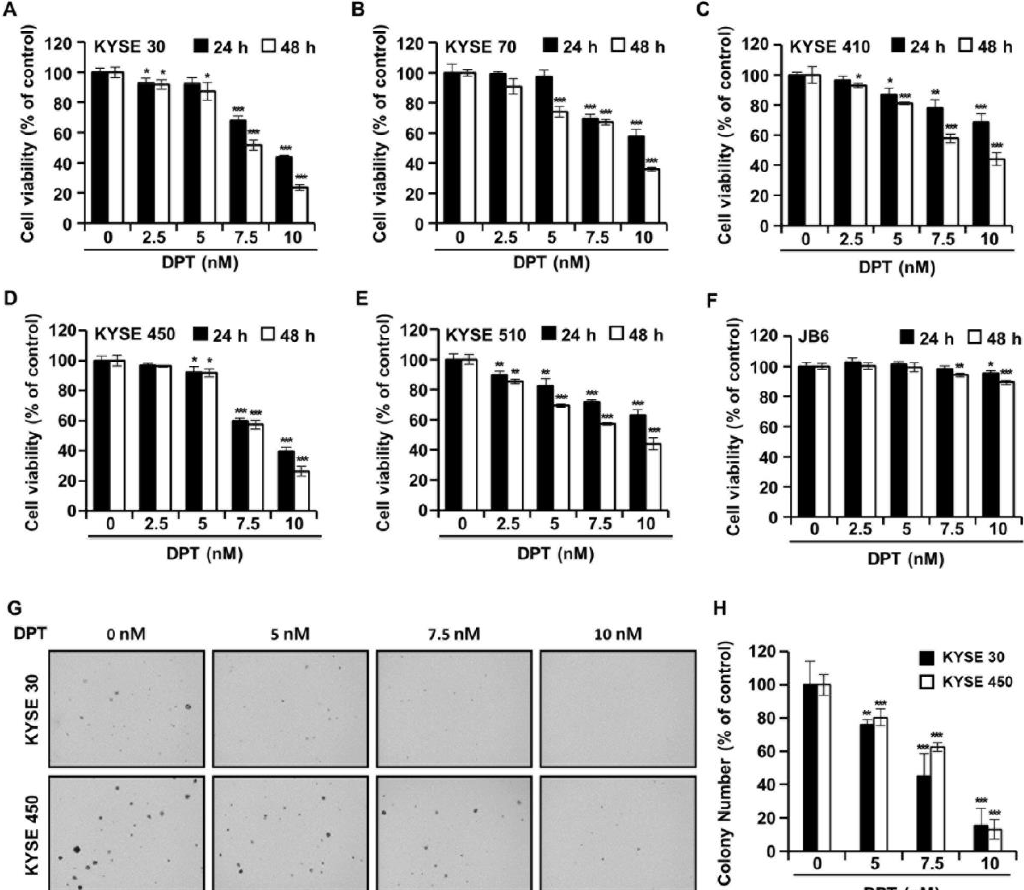
Figure 2. The effects of DPT on cell viability and anchorage-independent growth capability in ESCC cells. ( A – F ) Cell viability was determined after treatment with 0, 5, 7.5, and 10 nM of DPT for 24 and 48 h in JB6 cells and various ESCC cell lines, including KYSE 30, KYSE 70, KYSE 410, KYSE 450, and KYSE 510. MTT assay was used to assess JB6 and ESCC cell viability. ( G , H ) Cell anchorage-independent growth capability was evaluated by soft agar assay. KYSE 30 and KYSE 450 cells were incubated with DMSO or DPT (5, 7.5, and 10 nM) for 2 weeks. All data are shown as mean ± SD from three independent experiments. * p < 0.05, ** p < 0.01, and *** p < 0.001 compared to cells without DPT treatment.